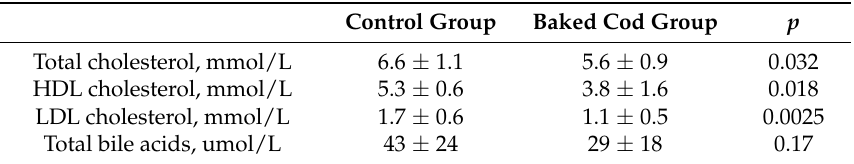
Table 4. Serum concentrations of cholesterols and total bile acids.